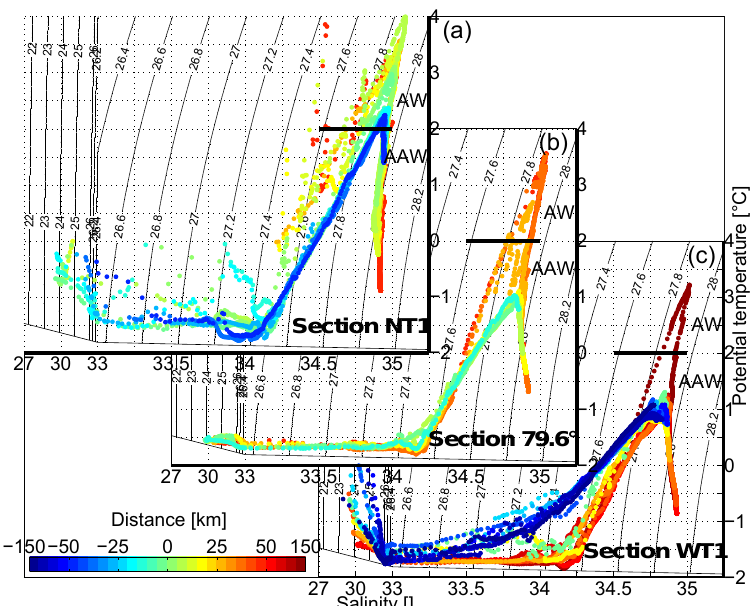
Figure 6. Potential temperature–salinity diagrams for three sections crossing the east Greenland shelf break (WT1, 79.6 ◦ N and NT1). Individual casts are colour coded depending on their distance to the east Greenland shelf break (positive = offshore). Please note that the x axis changes scale at 33. The solid black line shows the water-mass boundary between AW and AAW (see Table